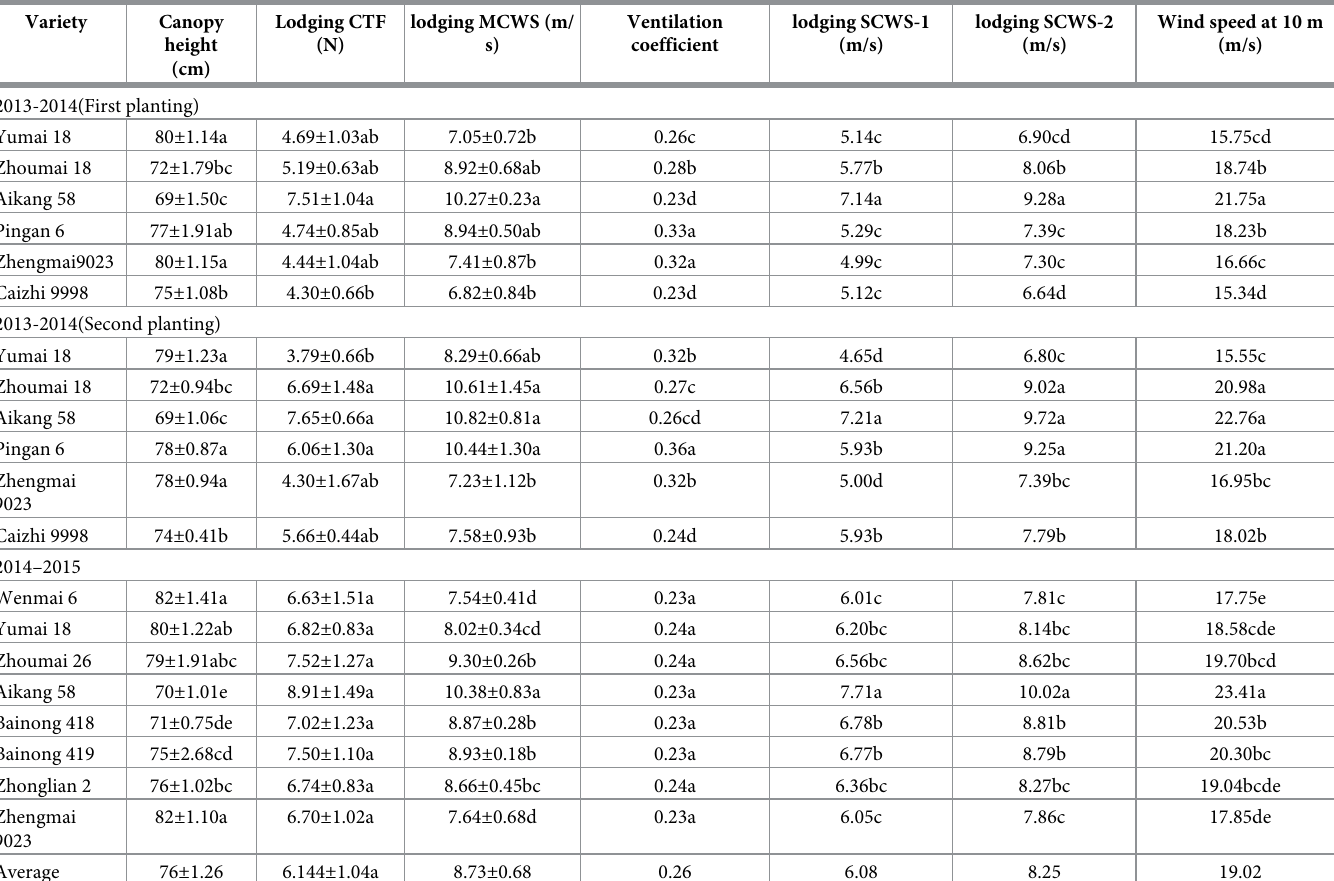
Table 3. Wind tunnel simulation experiments for lodging resistance during